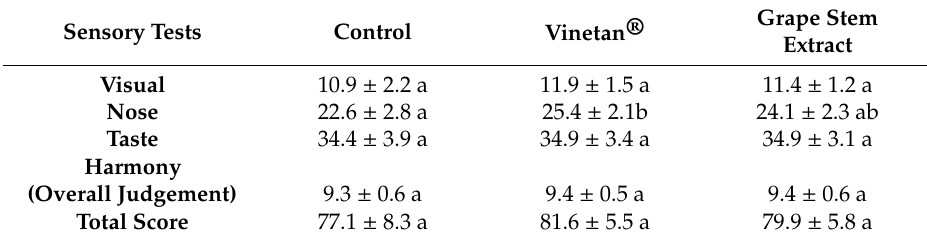
Table 6. Results of the sensory test of wines produced with only SO 2 at usual concentrations (control), or with grape stem or Vinetan ® extracts and reduced doses of SO 2 , preserved for 12 months in a bottle (Mean ± SD, n =